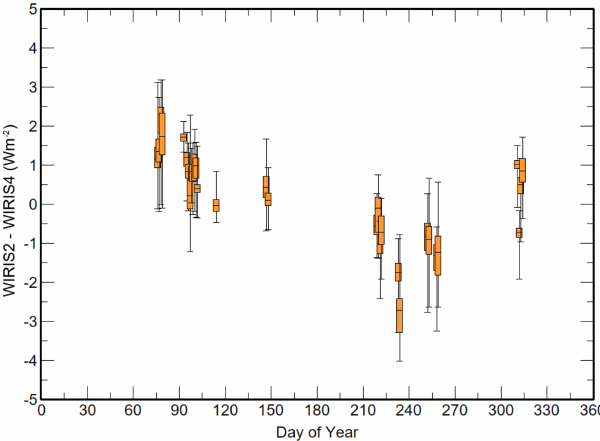
Figure 1. Statistics for the difference between W IRIS2 and W IRIS4 for every simultaneous irradiance in 2020 in box–whisker